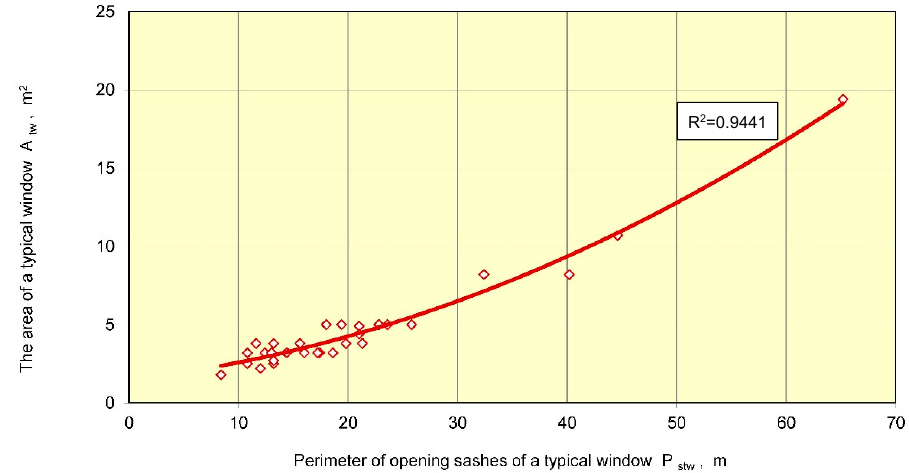
Figure 5. Relations between the area of a typical window A tw and perimeter of opening sashes of a typical window P stw in education buildings.